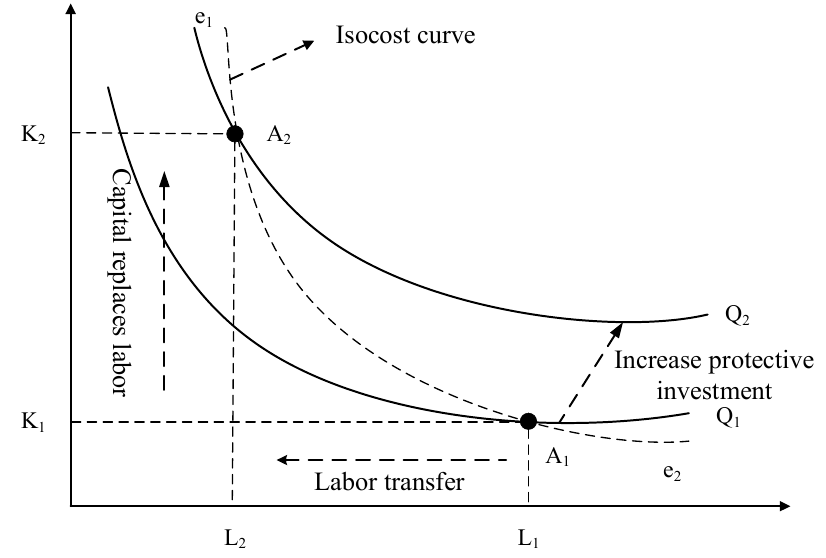
Figure 1. Mechanisms of impact of agricultural socialized services on agricultural production.